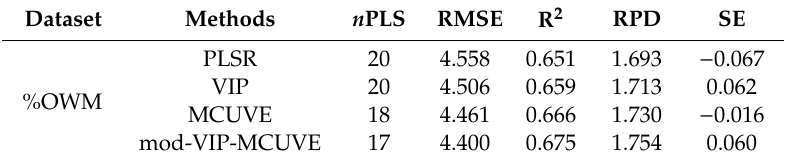
Table 3. The RMSE, R 2 , RPD, and SE in variable selection methods using %OWM data. Dataset Methods